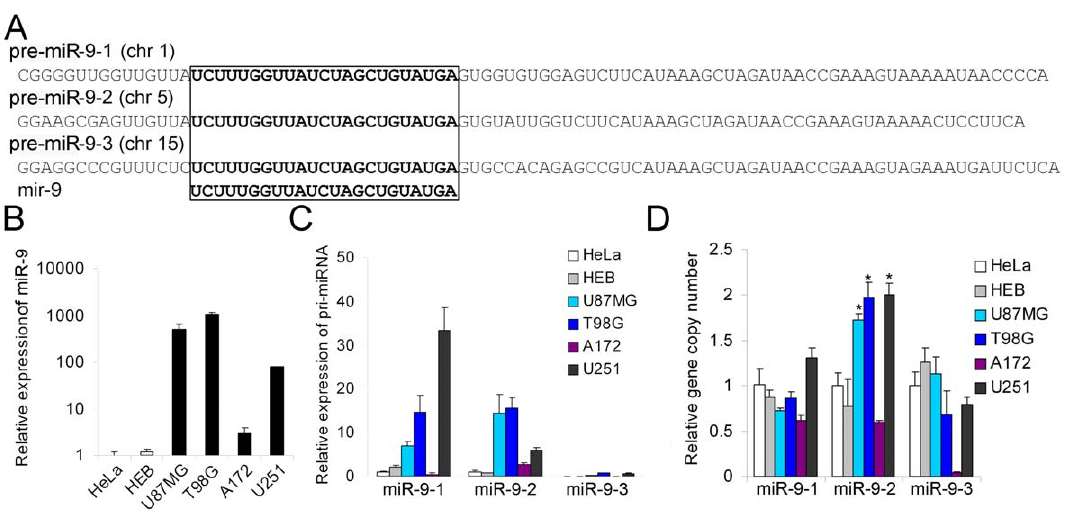
Figure 1. MiR-9 is highly expressed in glioma cell lines. (A) Schematic representation showing that miR-9 can be generated by the processing of any of the three primary transcripts encoded by three distinct genes (miR-9-1, miR-9-2 and miR-9-3). (B and C) The expression levels of mature miR- 9 as well as pri-miR-9-1, pri-miR-9-2 and pri-miR-9-3 were determined in the human cervical carcinoma cell line (HeLa), normal human glial cell line (HEB) and four glioma cell lines (U87MG, T98G, A172 and U251) by quantitative RT-PCR (mean 6 SD, n=3). (D) Genomic DNA was extracted from the six cell lines (HeLa, HEB, U87MG, T98G, A172 and U251), and the gene copy numbers of miR-9-1, miR-9-2 and miR-9-3 were determined by quantitative real-time PCR (mean 6 SD, n=3). *, P , 0.05, two-tailed unpaired Student’s t test, relative to HEB and